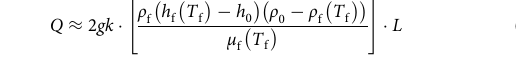
We assume that fl uids are over-pressured at any depth in the lower reservoir, i.e. the lambda factor ( λ ) 62 is comprised between ~0.35 (hydrostatic pore pressure) and 1 (lithostatic pore pressure). According to this assumption, Eq. (1) can be rewritten as with ρ r , the averaged density of the upper crust. Using an average basalt density of ρ r = 2900 kg m − 363,64 and an average viscosity of ~1 to 2 ×10 − 4 Pas − 1 for both the supercritical fl uid and the overlying boiling water 65 we fi nd from Eq. (2) an estimated permeability K comprised between ~10 − 13 and ~9× 10 − 13 m 2 . b. From pore-pressure diffusion in a seismic swarm. We can also estimate the permeability in the Reykjanes crust from the volume of the independent seismic bursts themselves, taking into account a pore-pressure diffusion hypothesis (Fig. 5).